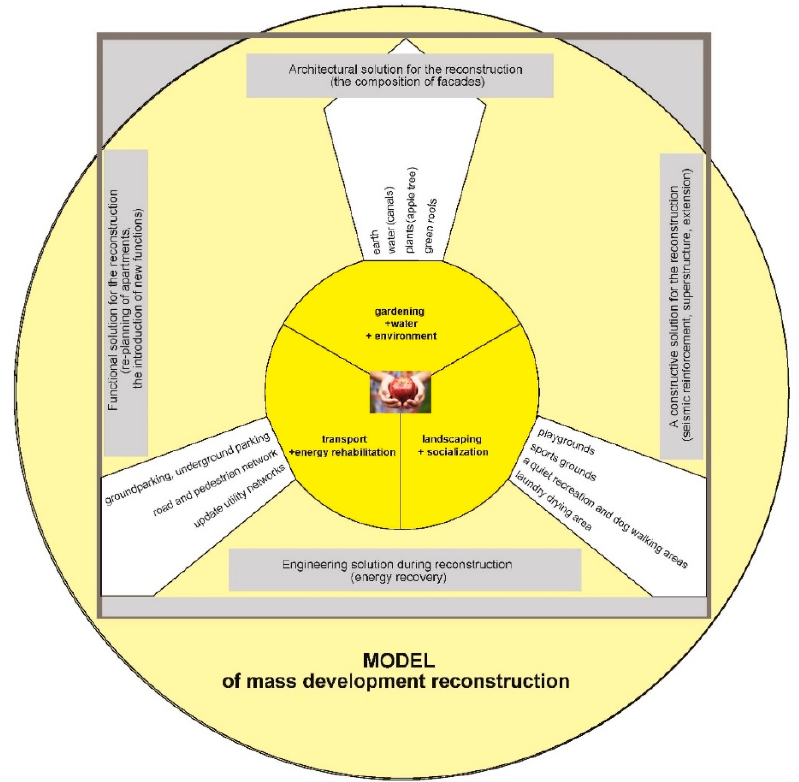
Figure 16. Model of reconstruction of mass residential development in Almaty (Author’s material).